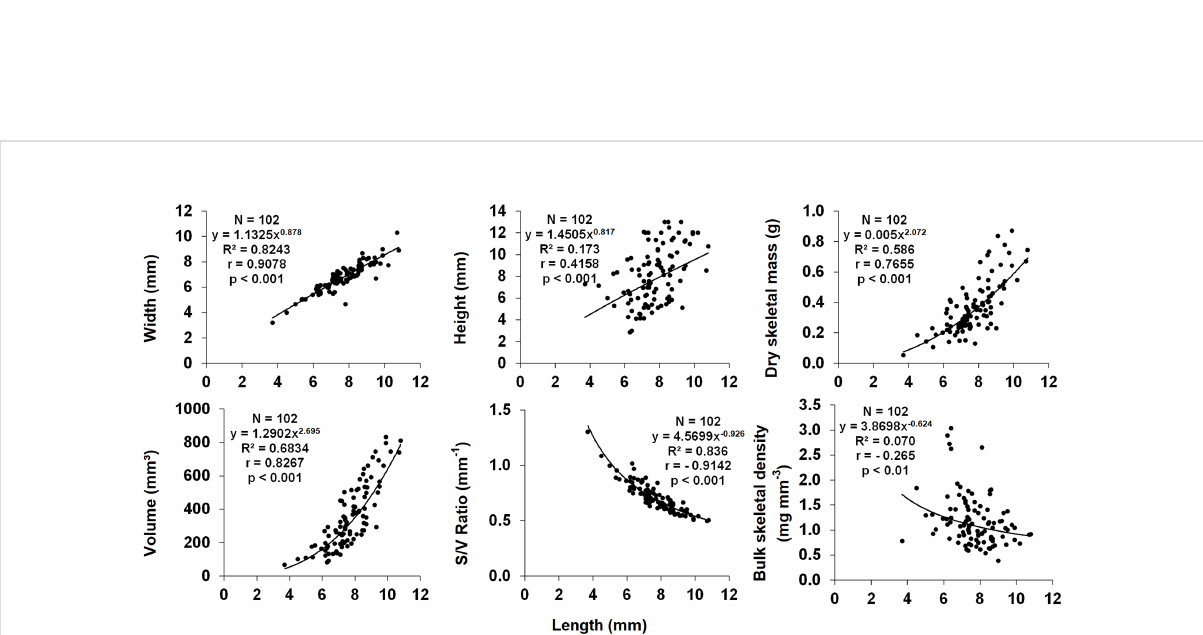
FIGURE 7 Dependence of biometric parameters on polyp length. N, number of individuals; R 2 , coef fi cient of determination; r, Pearson correlation coef fi